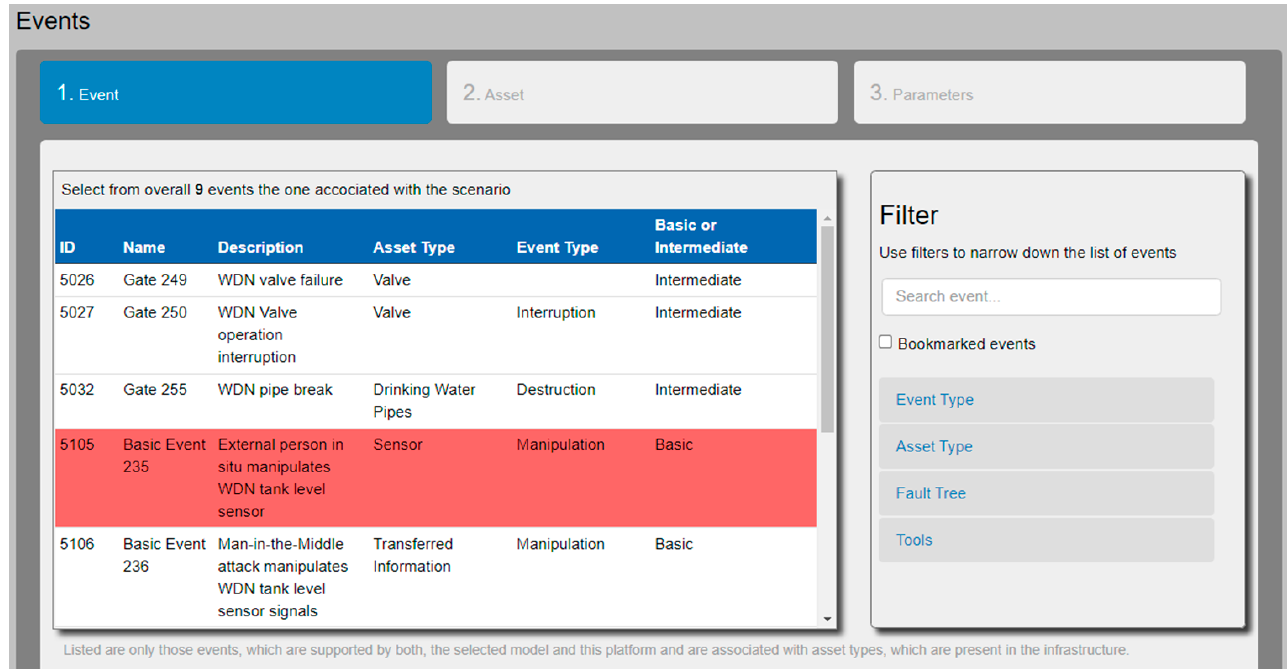
Figure 3. Selection of the risk event of RS 1 proposed by the fault tree within the Scenario Planner.